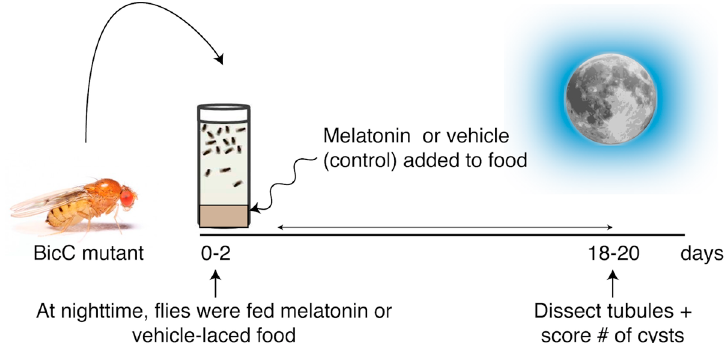
Figure 1. Protocol for testing the melatonin anti-cystic activity . BicC Δ /YC33 and BicC Δ /IIF34 flies (aged 0–